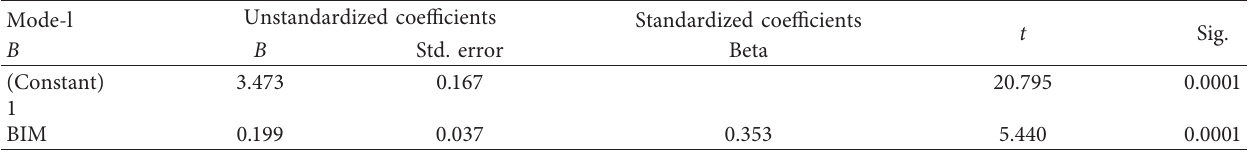
Table 9: Linear regression showing impact on scheduling